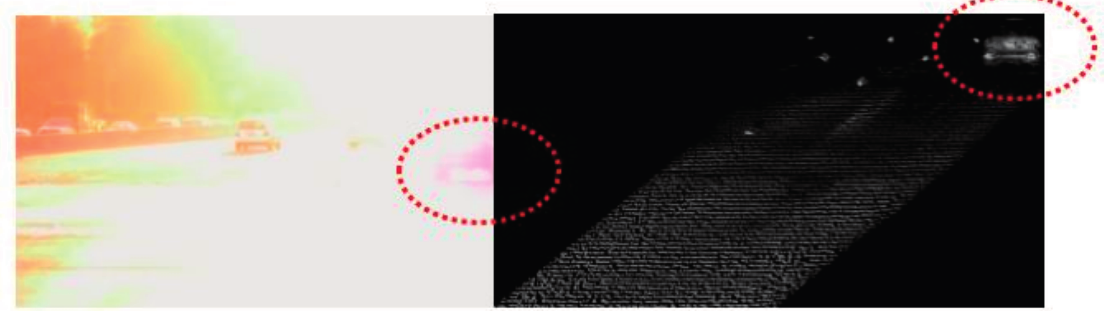
Figure 1. 2D camera vs. 3D Flash LIDAR